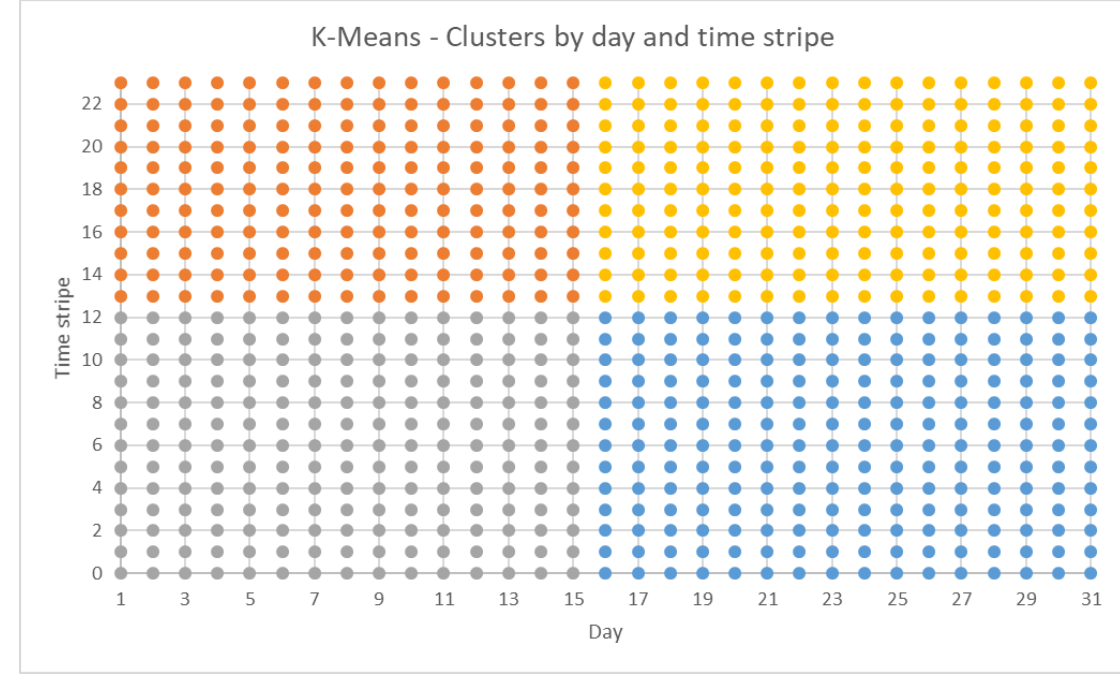
Figure 5. Source: Author’s elaboration.